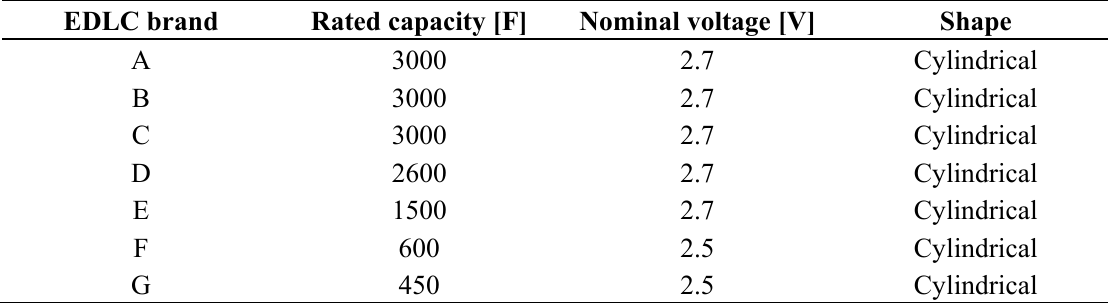
Table 6. Specifications studied EDLCs.